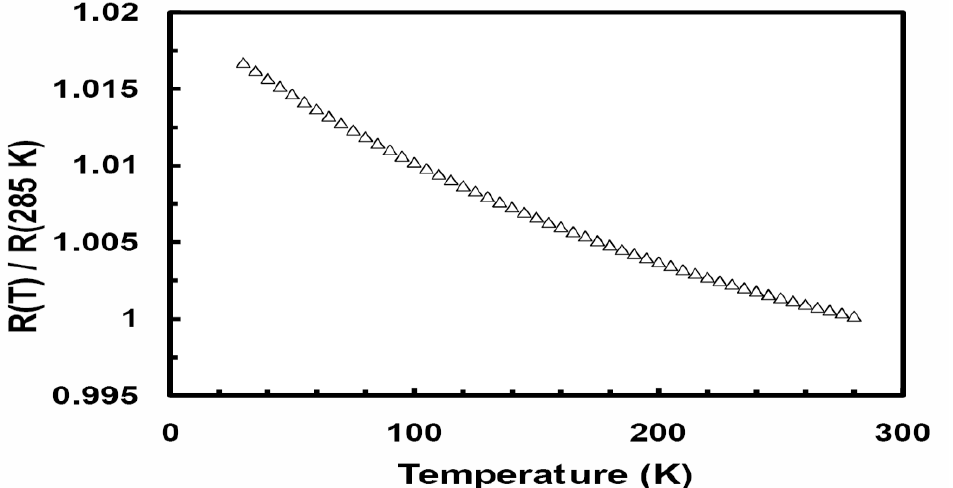
Fe Zr metallic glass. 0.25 0.75 3